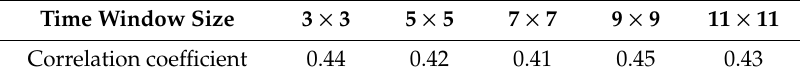
Figure 5. Horizon curve and mean curvature attribute with 2% noise: ( a ) Horizon curve and ( b ) mean curvature attribute of different time windows with 2% noise.